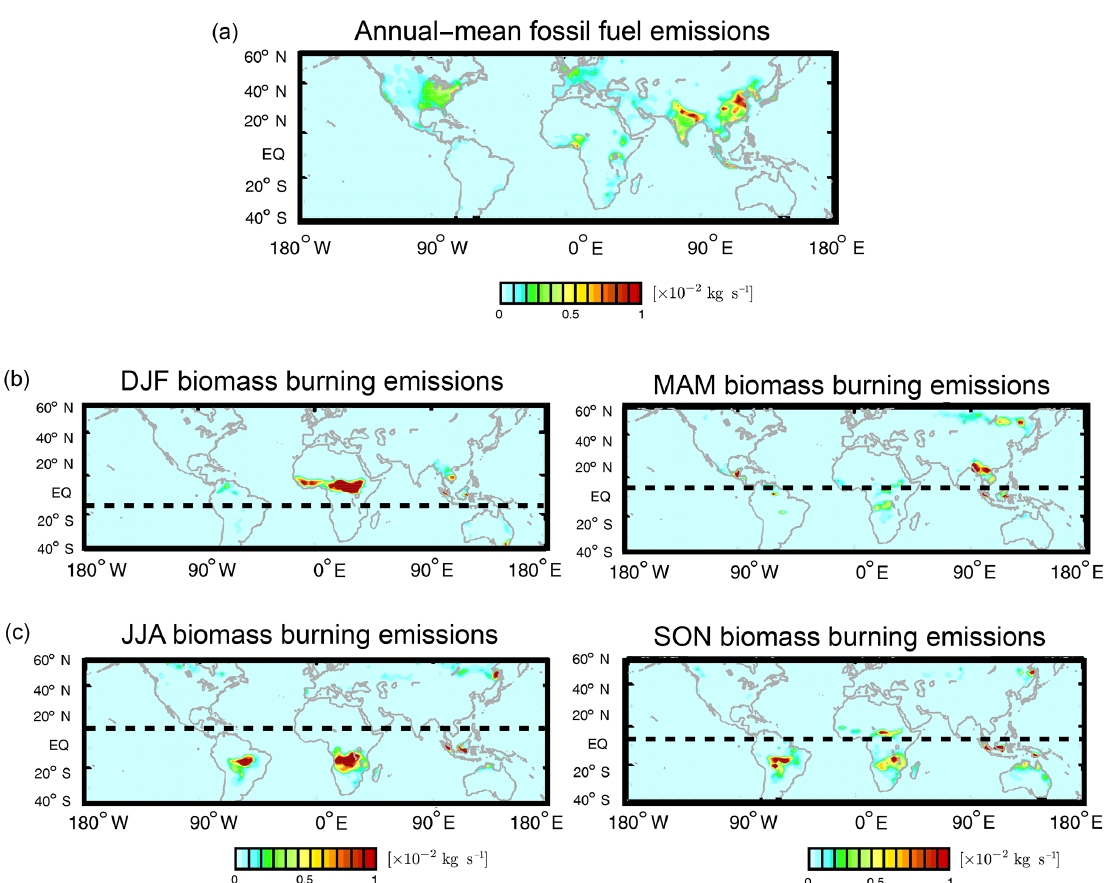
Figure 1. Annual-mean anthropogenic CO emissions (kgs − 1 ) from fossil fuels (a) and seasonal-mean biomass burning CO emissions for the different seasons (kgs − 1 ) ( b and c ). The dashed line shows the approximate position of the Intertropical Convergence Zone (ITCZ) in the different